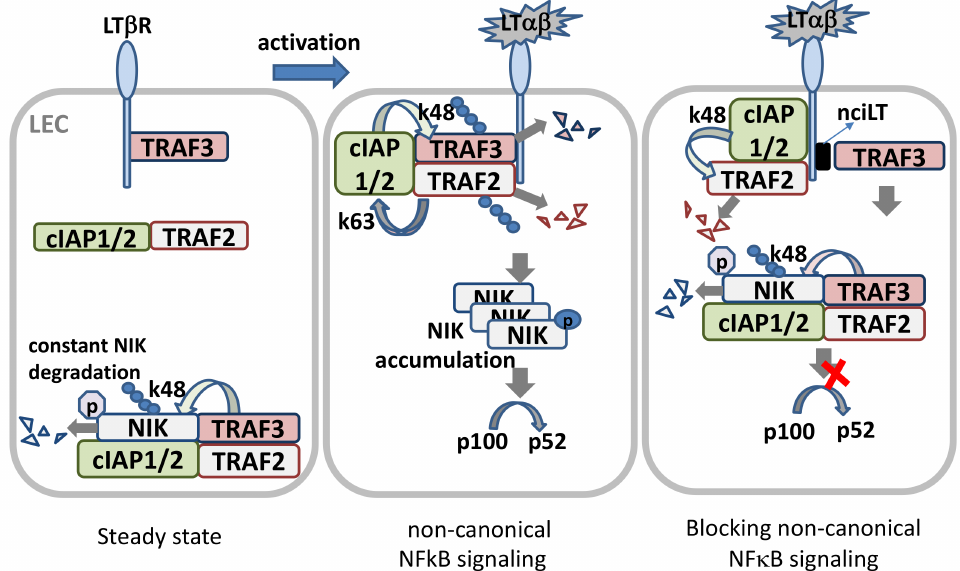
Figure 3. LT β R signaling in LEC. In steady state, newly synthesized NIK is rapidly bound by TRAF3 and targeted to the TRAF-cIAPs E3 ubiquitin ligase complex for K48-polyubiquitination and proteasomal degradation, where TRAF2 bridges TRAF3 and cIAPs. Low level NIK is unable to process p100 under normal conditions. In ligand (LT αβ or LIGHT)-stimulated LECs, the TRAF-cIAPs complex is recruited to the LT β R where cIAP1/2 is activated by TRAF2-mediated K63 ubiquitination, and the activated cIAP1/2 then targets TRAF3 for K48 ubiquitination and degradation. With the lack of TRAF3, de novo synthesized NIK accumulates and is activated via trans-phosphorylation. NIK then activates IKK α , leading to p100 processing and nuclear translocation of RelB/p52. Masking the TRAF3-binding site of LT β R by permeable blocking peptide nciLT leads to TRAF3 targeting NIK for degradation, and hence p100 processing is